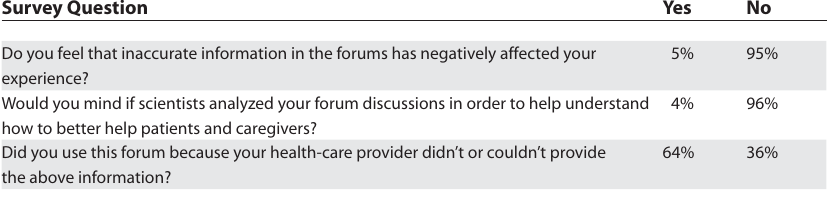
Table 2. BrainTalk Communities Epilepsy Support Group: Responses to a Survey of